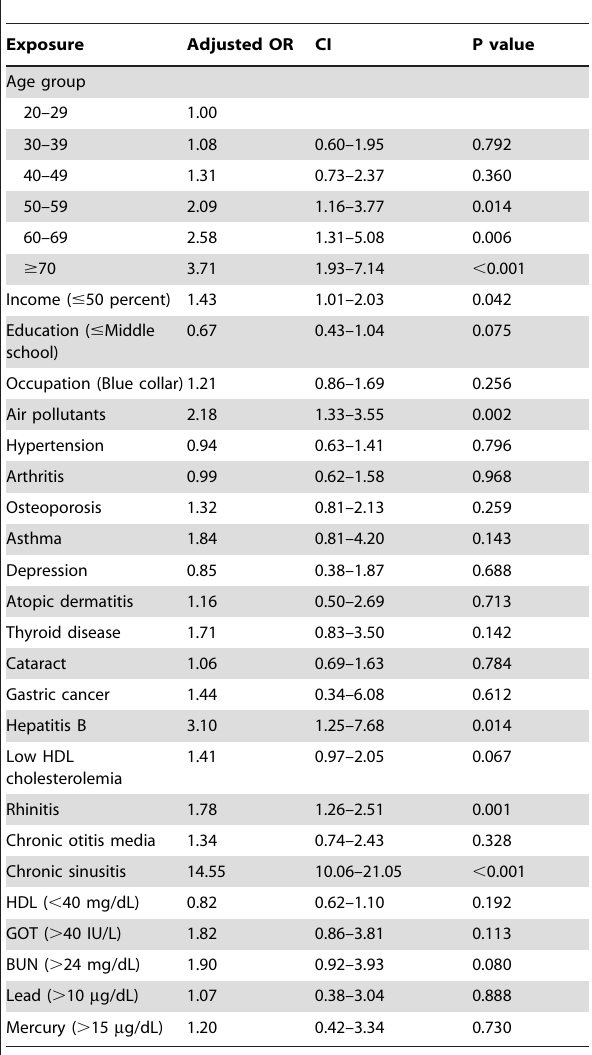
Table 4. Adjusted odds ratio for the association between olfactory dysfunction and risk